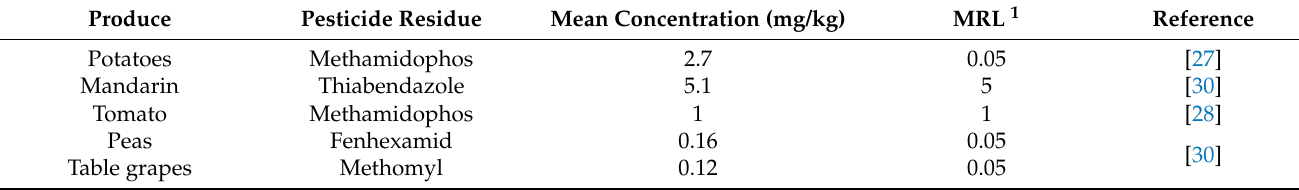
Table 3. Levels of pesticide residues in Peruvian produce. Adapted from multiple